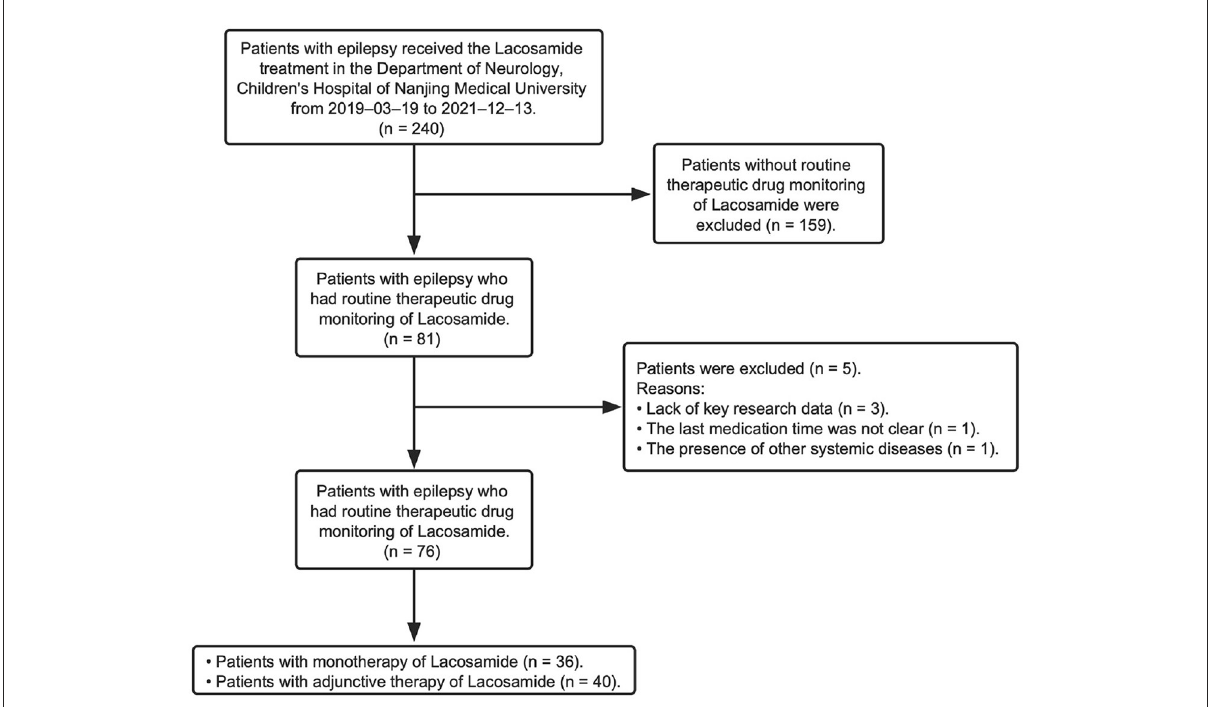
FIGURE1 Numbers of patients who were eligible for this